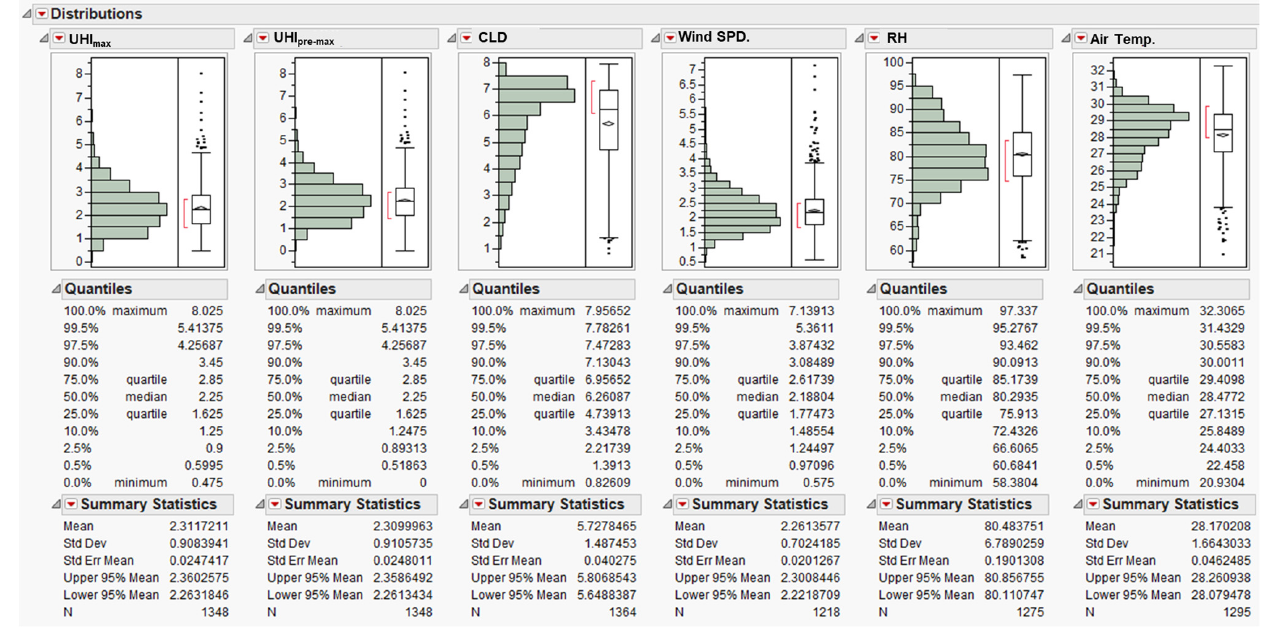
Figure 2. Distribution analysis and summary statistics of meteorological elements and UHI indicators in summer (mean values of four urban stations of HKOH, JKB, SHA, and TUN, summer, 2002–2012. n corresponds to the number of daily observations during the study period, and incomplete observations were excluded).